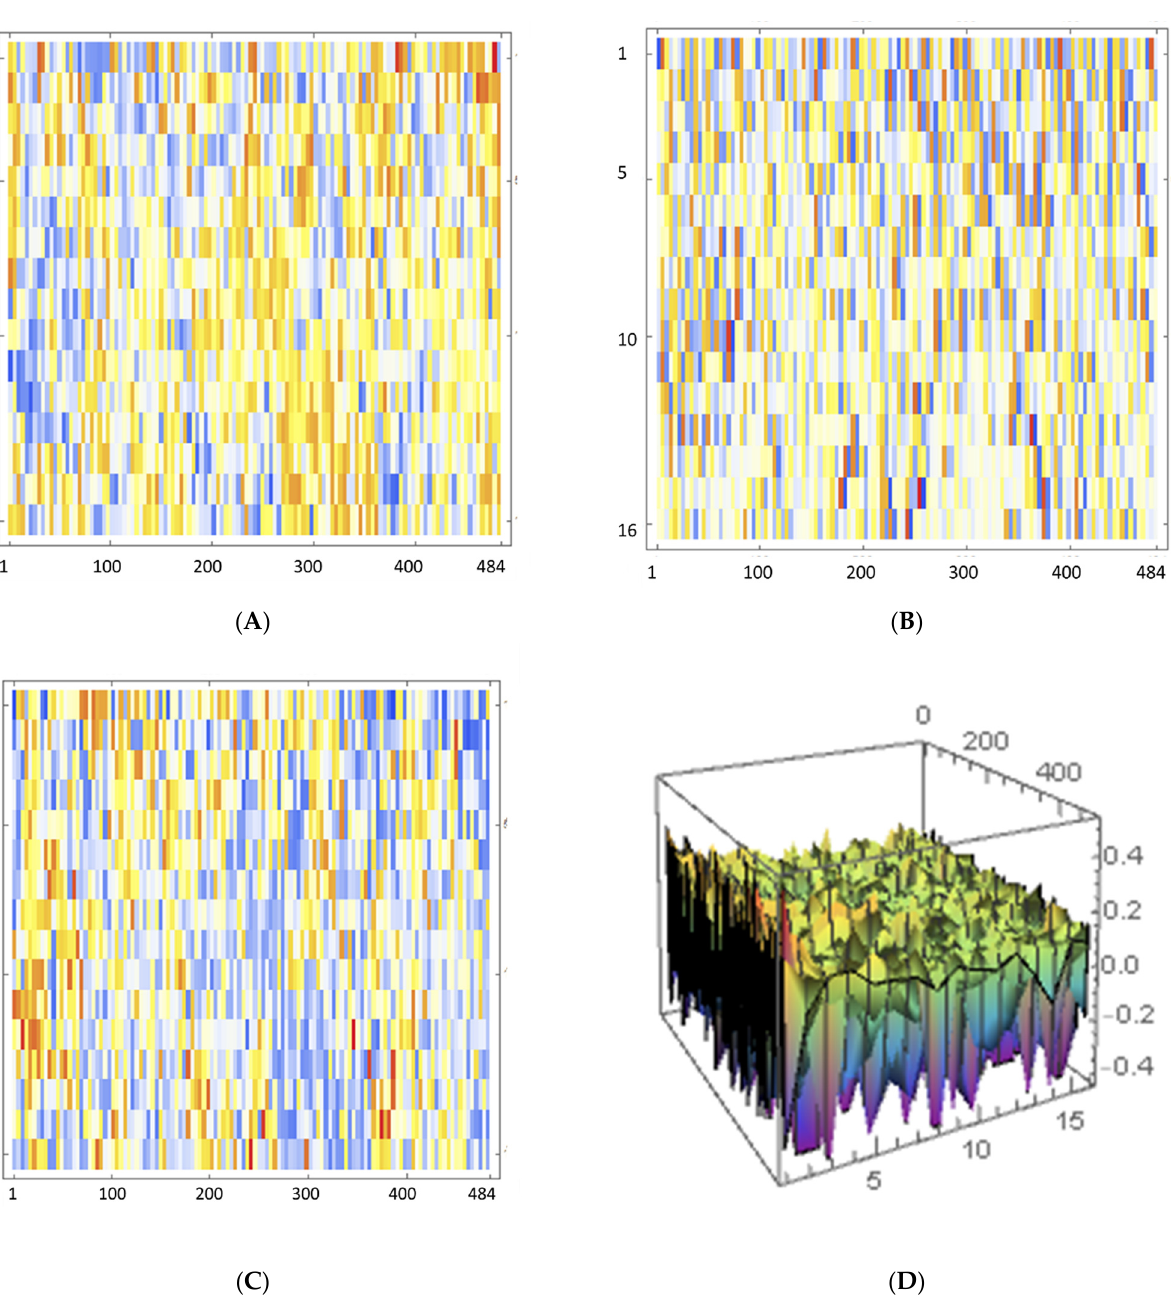
Figure 3. Application of the model of state-space regressions (Equations (6) and (7)) to one brokerage tape. The horizontal coordinate is the observation day and the vertical coordinate is the price change bucket from 0 to 8 CNY in units of 0.5 CNY. ( A ) Temperature map of an original signal. Orange-yellow colors describe a positive day-to-day correlation, while light and dark blue colors describe a negative correlation. ( B , D ) predictions of the model, ( C ) model residuals.